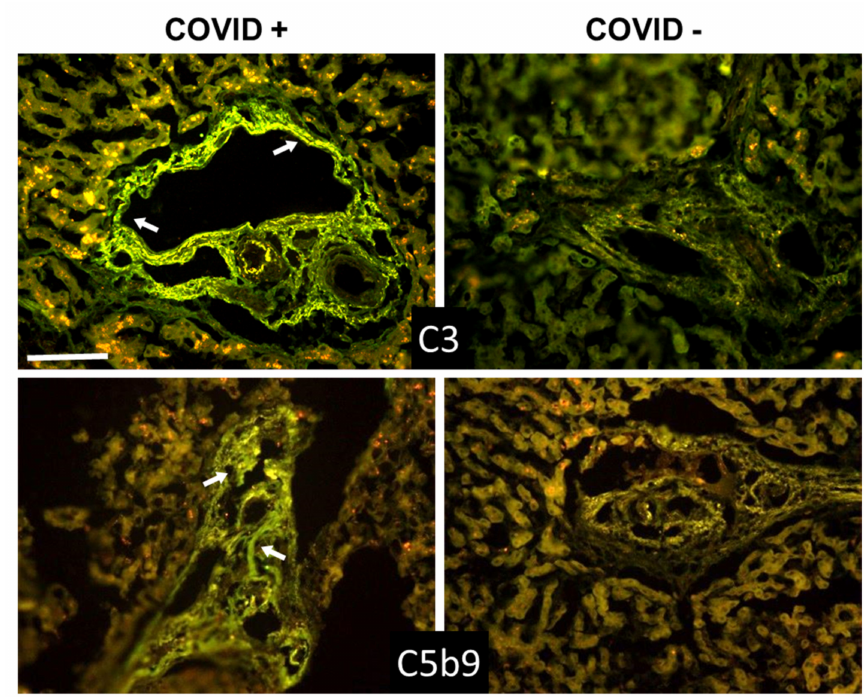
Figure 6. Detection of C3 and C5b-9 in liver sections by immunofluorescence analysis. The